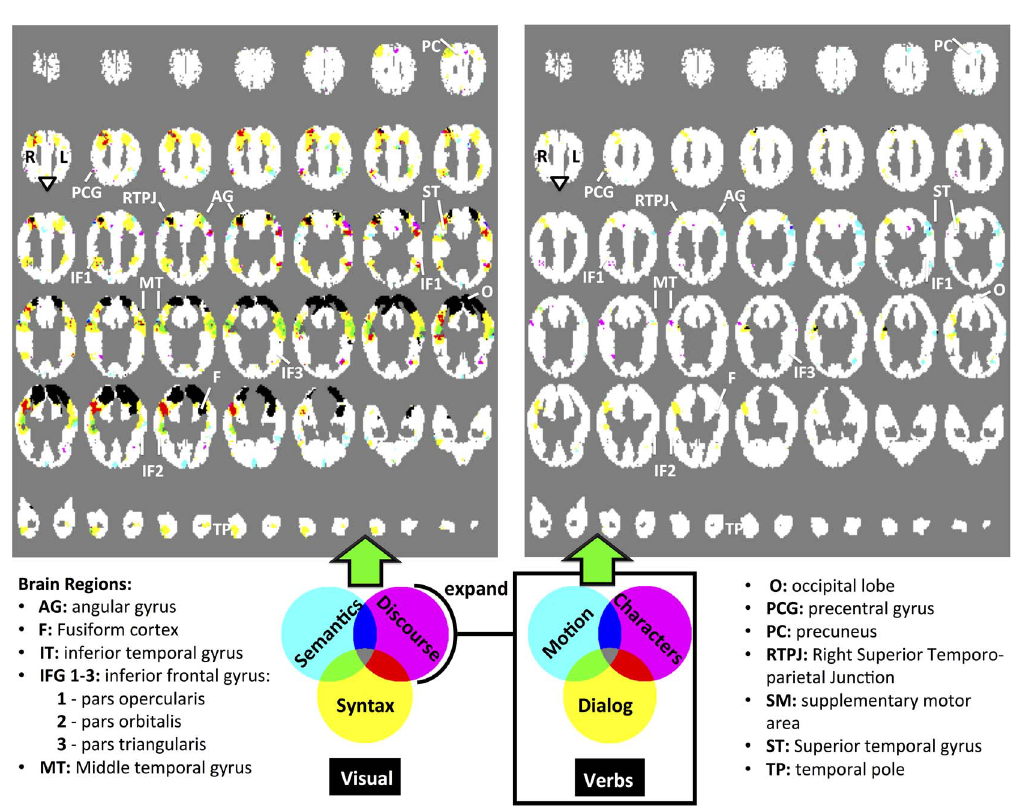
Figure 3. Accuracy maps revealing different patterns of representation of different reading processes. ( Left ) Voxels with significantly higher than chance classification accuracy when using different types of story elements as features, shown in different colors corresponding to the type of story elements. The brain used here is a superset of the brain of the 8 subjects, i.e. the union of all the voxel locations in the 8 brains. The slices are drawn such that they increase in the Z MNI-coordinate when going right to left, then bottom-up. Within each slice, the top of the slice corresponds to the posterior of the brain, and the right side of the slice corresponds to the left side of the brain. Each voxel location represents the classification done using a cube of 5 | 5 | 5 voxel coordinates, centered at that location, such that the union of voxels from all subjects whose coordinates are in that cube are used. ( Right ) Voxels with significantly higher than chance classification accuracy when using different types of discourse elements as features, shown in different colors corresponding to the type of discourse elements.